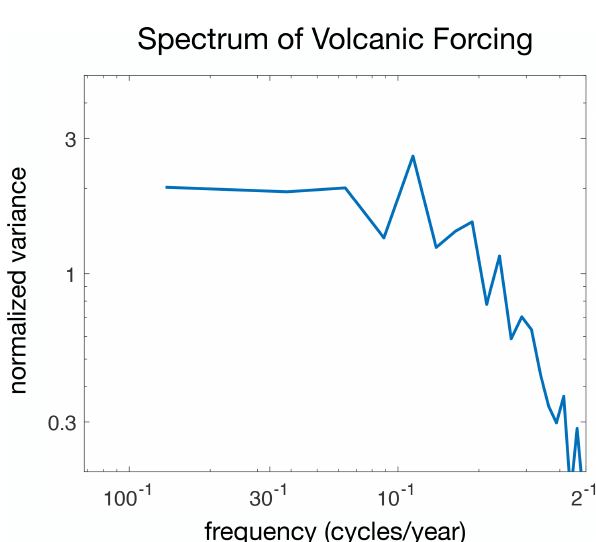
Figure A3. Power spectrum of volcanic forcing generated from time series of volcanic aerosol concentrations in the LME (courtesy of John